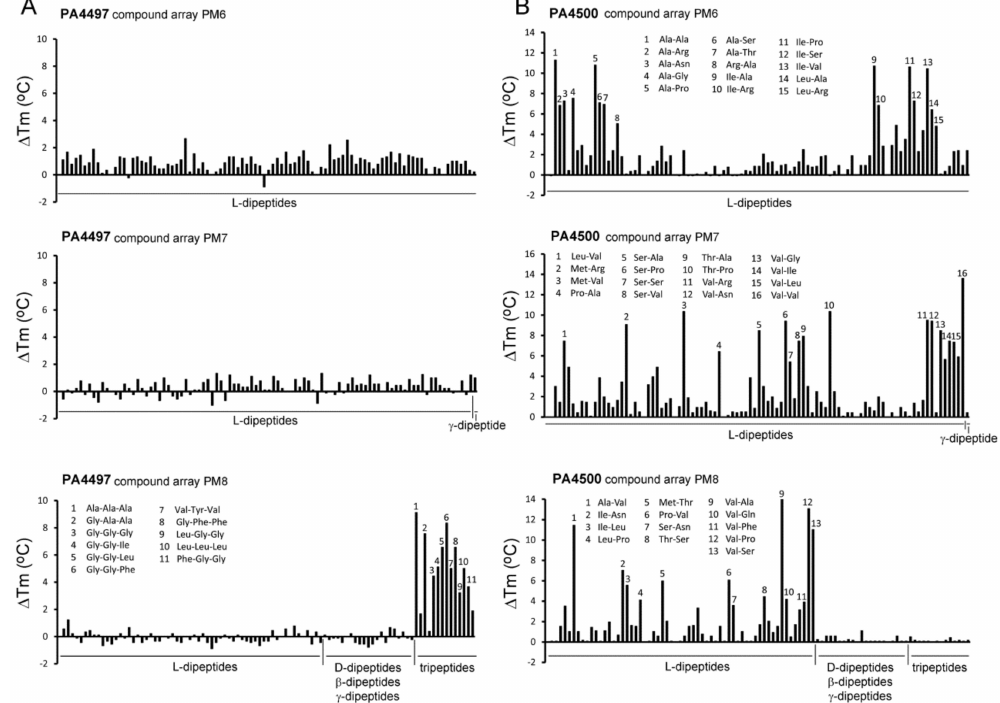
Figure 7. Thermal shift ligand binding studies of the solute binding proteins PA4497 and PA4500. Shown are T m changes with respect to the ligand-free protein for PA4497 ( A ) and PA4500 ( B ). Compound arrays PM6, PM7, and PM8 that contain different di- and tripeptides were used. Peptides that caused major changes are annotated. The complete list of peptides that caused T m increases superior to 3 ◦ C is provided in Table S3. Microcalorimetric titrations of PA4500 with some dipeptides are shown in Figure